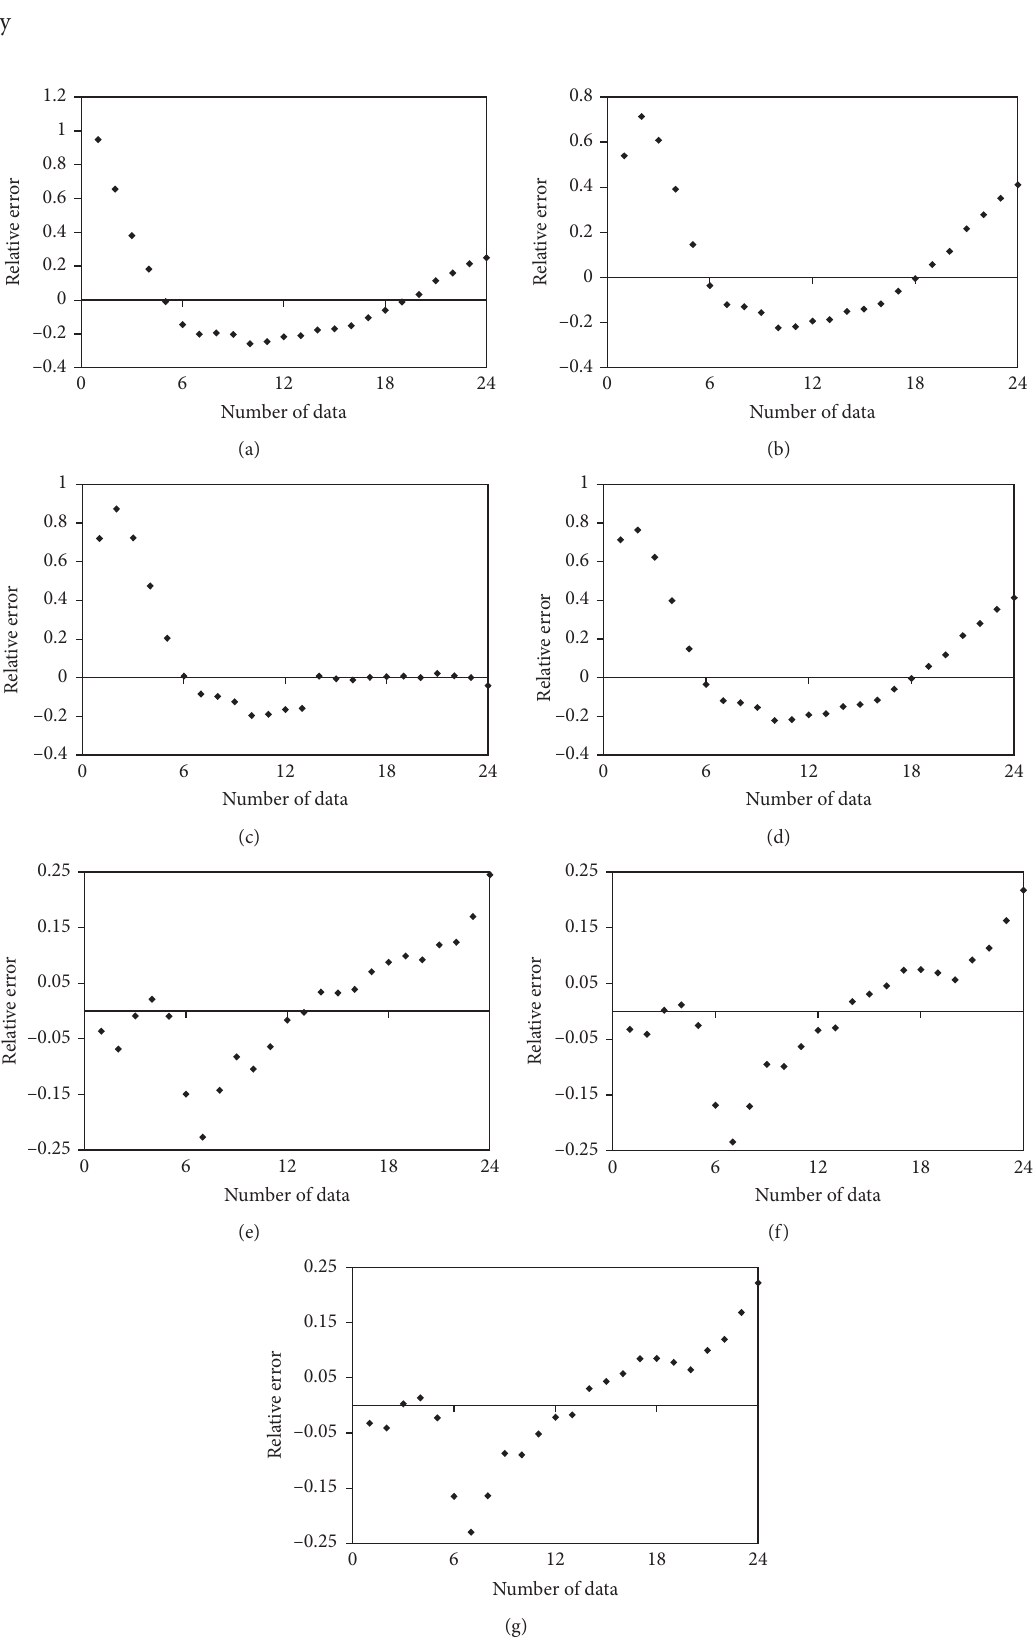
Figure 6: Comparison of relative errors of discharges predicted by different methods for Dataset 7. (a) Conventional method. (b) EA. (c) RF. (d) MHBMO. (e) ANN. (f) MGGP. (g)